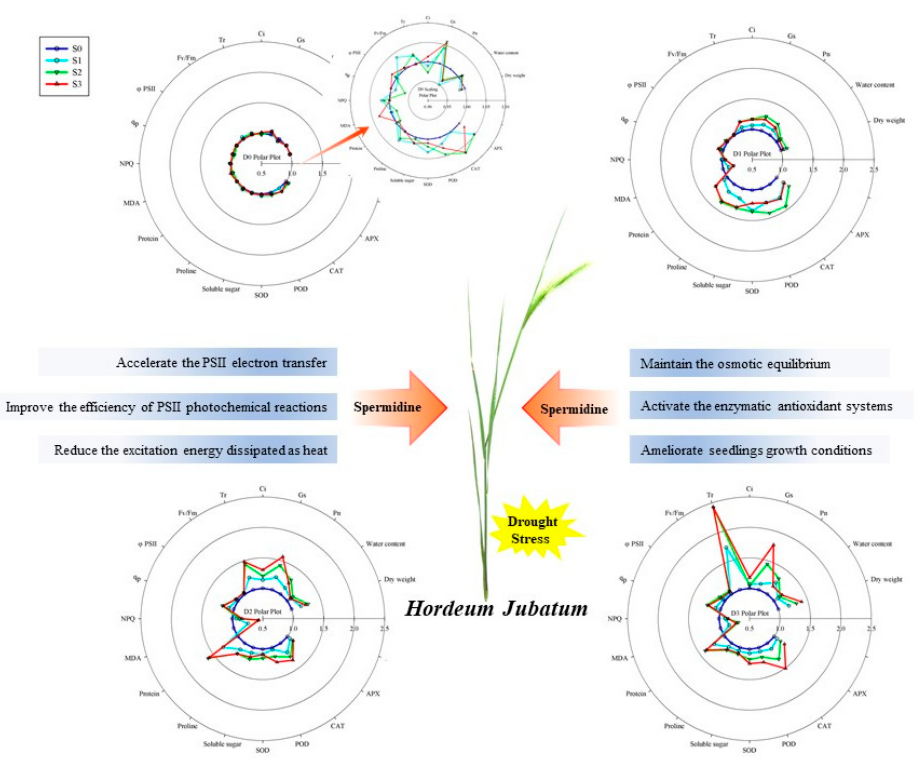
Figure 6. Diagram of the multiple roles of exogenous Spd in the drought tolerance of Hordeum jubatum shoots. The polar plots show the effects of Spd pretreatment on the parameters under different drought times (D0, D1, D2, and D3 represent 0–15 d drought intensity with 5 d intervals). S0, S1, S2, S3 corresponds to exogenous spd concentration of 0, 0.5 mM, 1.0 mM, 1.5 mM respectively. All the data were normalized to those of the reference treatment (no pretreatment with Spd), and each reference variable was standardized by receiving a numerical value of 1. In order to facilitate observation, the D0 scaling polar plot represents D0 with refinement from 0.5~2.5 to